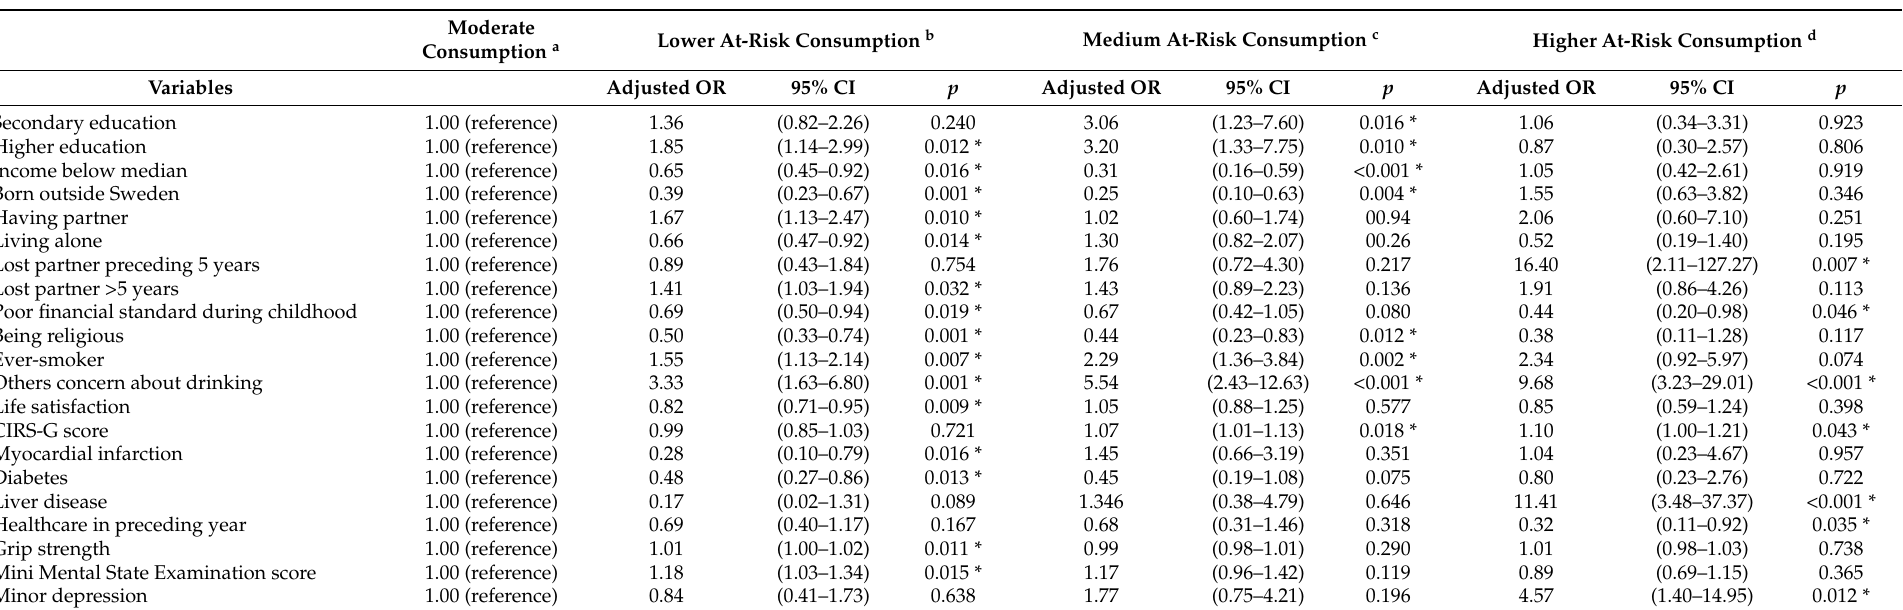
Table 5. Sociodemographic, social, and health-related factors associated with lower at-risk, medium at-risk, and higher at-risk consumption. Moderate Lower At-Risk Consumption b Medium At-Risk Consumption c Higher At-Risk Consumption Consumption a